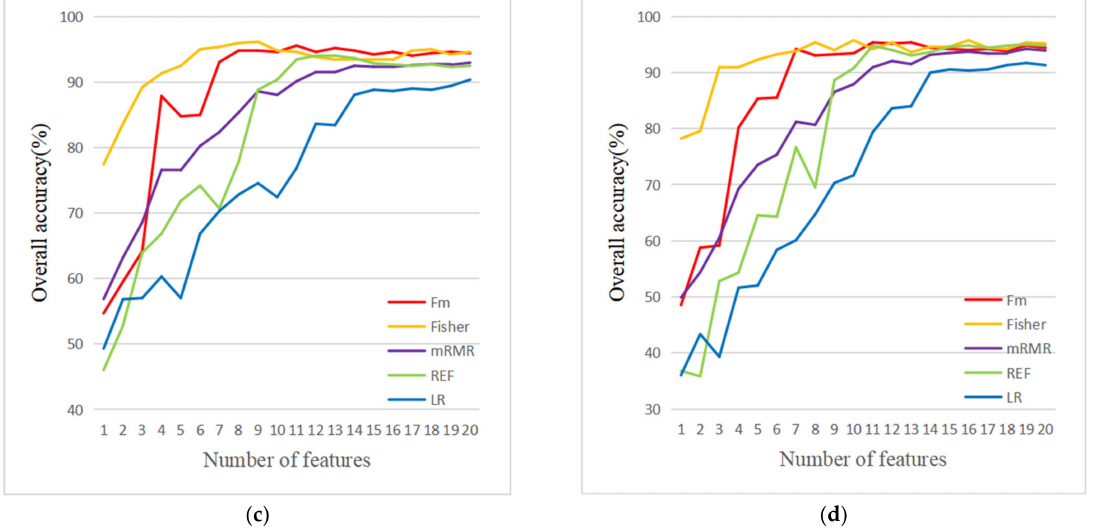
Figure 5. The variation trend of number of features and overall accuracy of five feature selection methods with different classifiers: ( a ) CART; ( b ) RF; ( c ) KNN; ( d ) SVM.